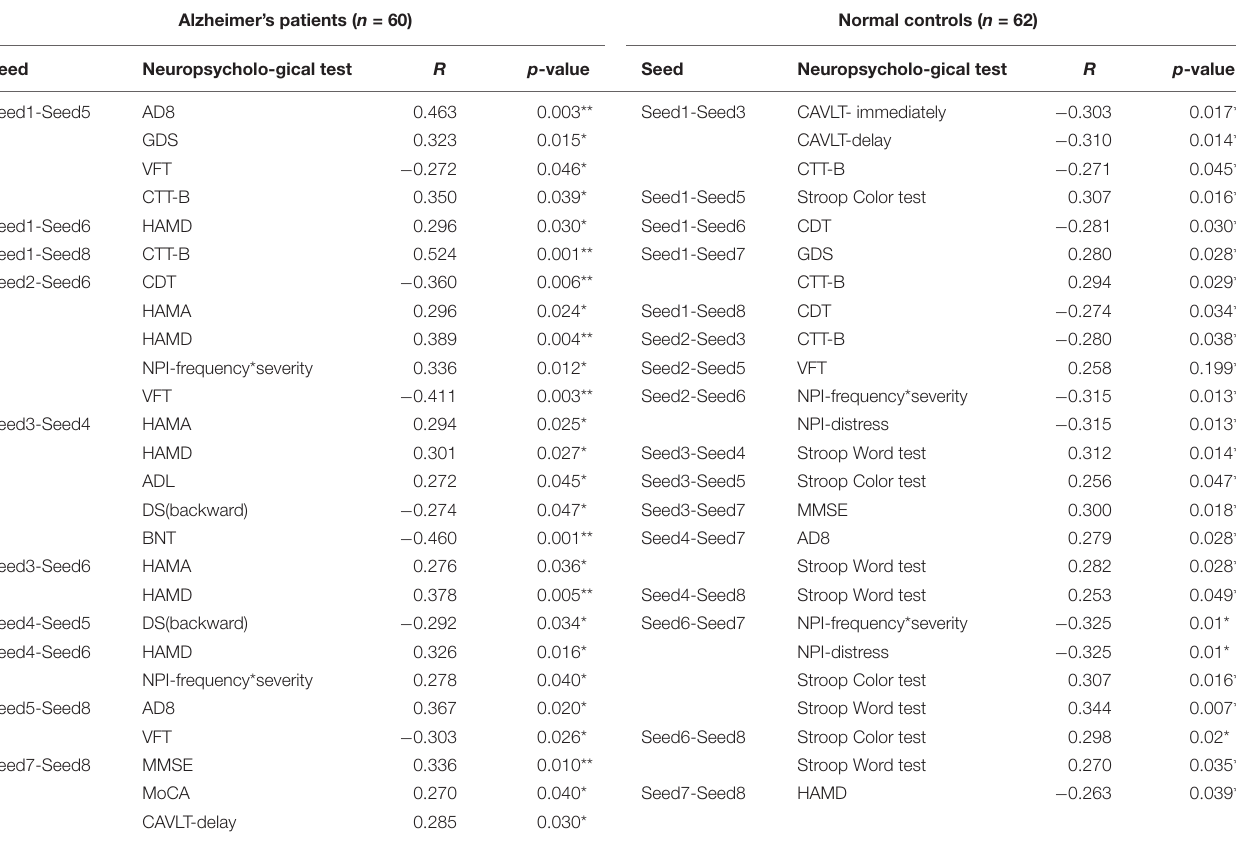
TABLE 2 | Pearson correlation analysis of RSFC within the ECN after iTBS stimulation in AD patients and normal controls. Alzheimer’s patients ( n =